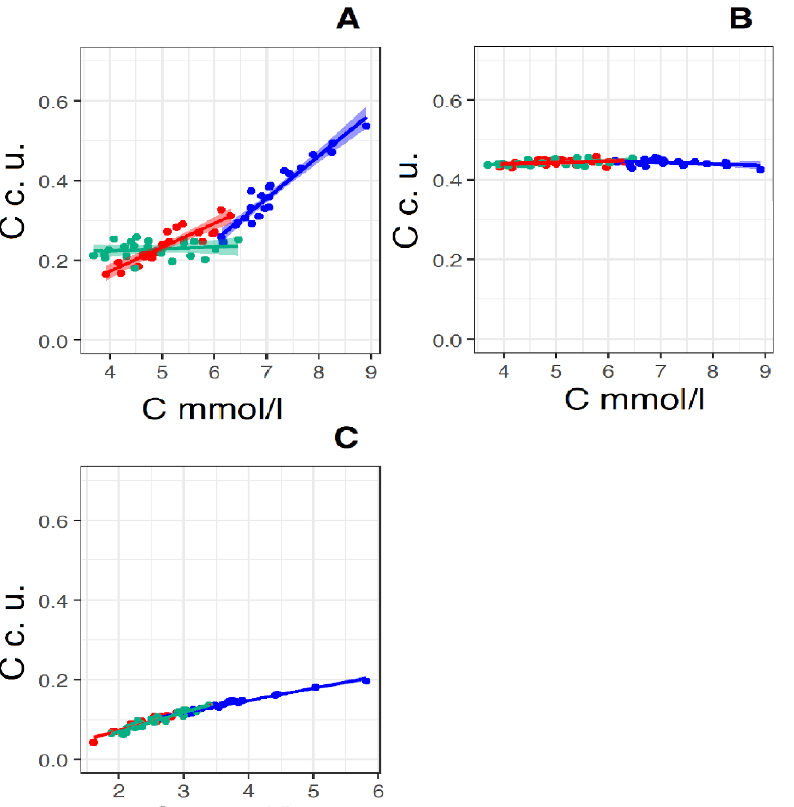
Figure 6. Linear regression lines of the pairs: “total cholesterol concentration ( X -axis) and relative concentration of exomeres ( Y -axis)” ( A ), “total cholesterol concentration ( X -axis) and relative concentration of exosomes ( Y -axis)” ( B ) and “total cholesterol concentration ( X -axis) and relative concentration of LDL” ( Y -axis) ( C ) ( X -axis in mmol/L, Y -axis in convention units — c. u., which is proportional square root of SIC) in the control group (Red straight N = 19) and in the groups “Before therapy” (Blue straight N = 22) and “After therapy” (Green straight N = 22). For pear “total cholesterol concentration and relative concentration of exomeres” in the control group linear regression equitation: y = 0.06x + 0.07, R2 = 0.81, p < 0.001, in the group “Before therapy” linear regression equitation: y = 0.11x − 0.39, R2 = 0.92, p < 0.001, in the group “After therapy” linear regression equitation: y = 0.005x + 0.20, R2 = 0.02, p < 0.01. For pear “total cholesterol concentration and relative concentration of exosomes” in the control group linear regression equitation: y = 0.035x + 0.43, R2 = 0.053, p < 0.01, in the group “Before therapy” linear regression equitation: y = 0.039x − 0.47, R2 = 0.082, p < 0.05, in the group “After therapy” linear regression equitation: y = 0.041x + 0.42, R2 = 0.16, p —ns (>0.05). For pear “total cholesterol concentration and relative concentration of LDL” in the control group linear regression equitation: y = 0.045x − 0.018, R2 = 0.94, p ≤ 0.0001, for group “Before therapy” linear regression equitation: y = 0.031x + 0.025, R2 = 0.097, p ≤ 0.0001, for